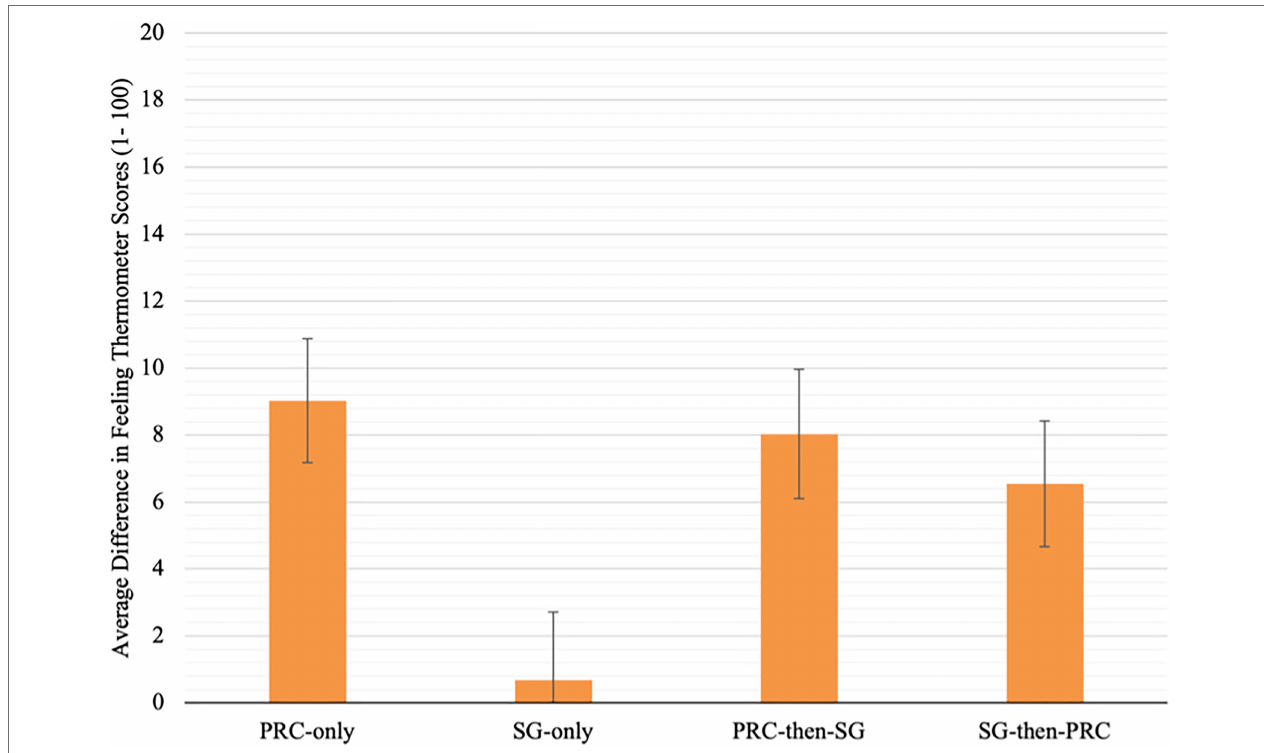
FIGURE 2 | Mean pre-to-post-change in feeling thermometer scores (1–100) for each embodiment condition. Error bars represent standard errors of the